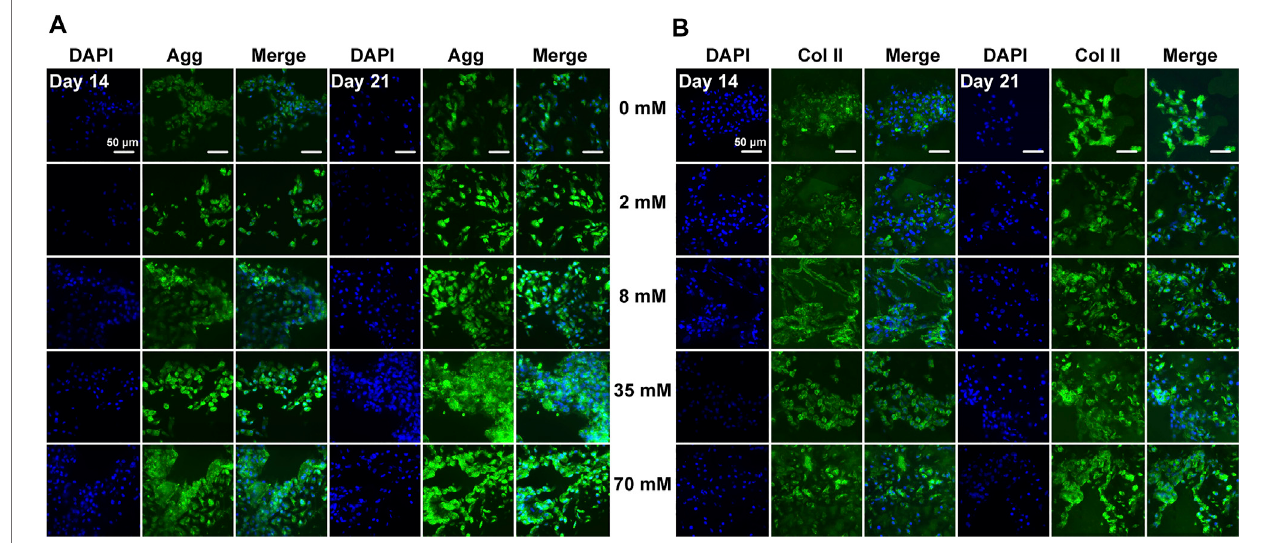
FIGURE4| Immuno fl uorescencestainingforthechondrogenicmarkersaggrecan (A) andtypeIIcollagen (B) ofchondrocytes.AggrecanandtypeIIcollagenwere stained green, and nuclei were stained blue. Scale bar = 50 µm.